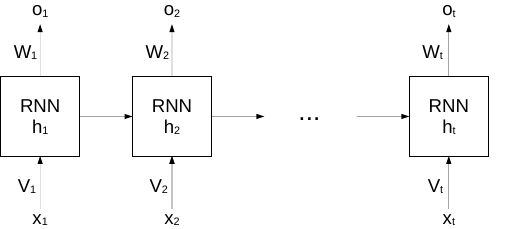
Figure 1. Structure of an RNN. Reproduced under CC-BY from